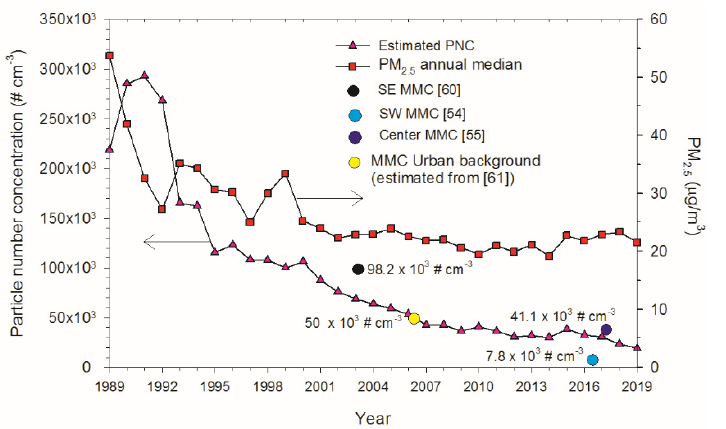
Figure 2. Annual PNC trends estimated from the medians of annual measured levels of CO and estimated (before 2004) and measured (after 2004) PM 2.5 registered in the MMC from 1989 to 2019. Source of PM 2.5 data was: http://www.aire.cdmx.gob.mx/default.php# (accessed on 4 June 2022).